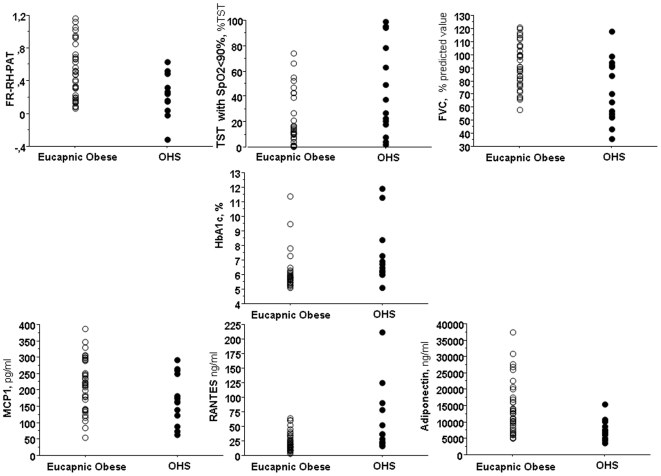
Comparison between Obesity Hypoventilation Syndrome (OHS) compared to eucapnic obese patients in RH-PAT, Sleep time spent with SpO2<90%, FVC (% predicted value), glycated haemoglobin, serum levels of RANTES, Adiponectin and MCP1.TST: total sleep time.